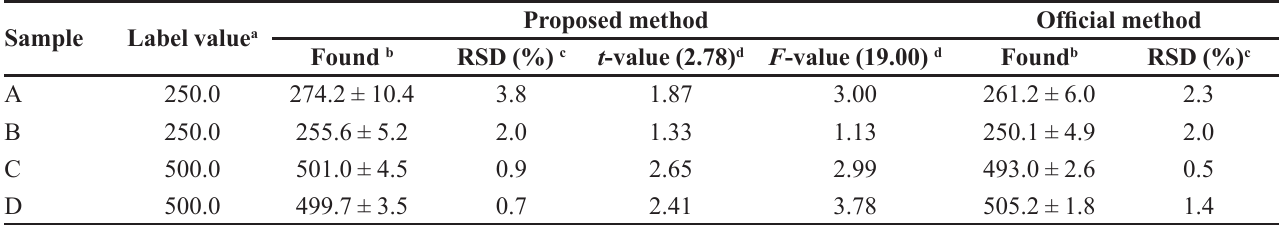
TABLE III - Determination of MTD in commercial pharmaceutical preparations Sample